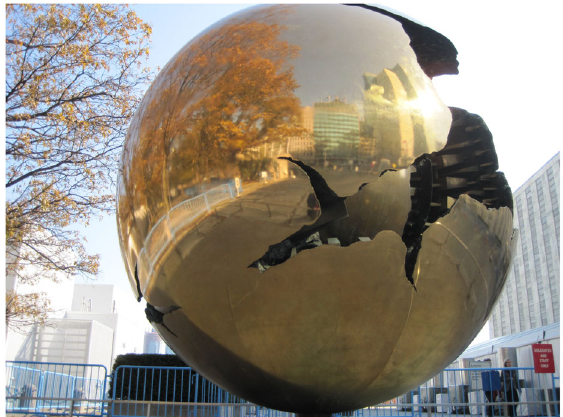
Fig. 4 A wounded planet is conveyed by Sphere within Sphere by Arnaldo Pomodoro, 1996, just outside the United Nations Headquarters in New York. Extant peace systems demonstrate the human capacities to create non-warring social systems and to solve common challenges through collaboration. An understanding of peace systems holds promise for facilitating cooperation and solidarity in addressing global pandemics, climate change, and ecosystem collapse. Reproduced with permission of